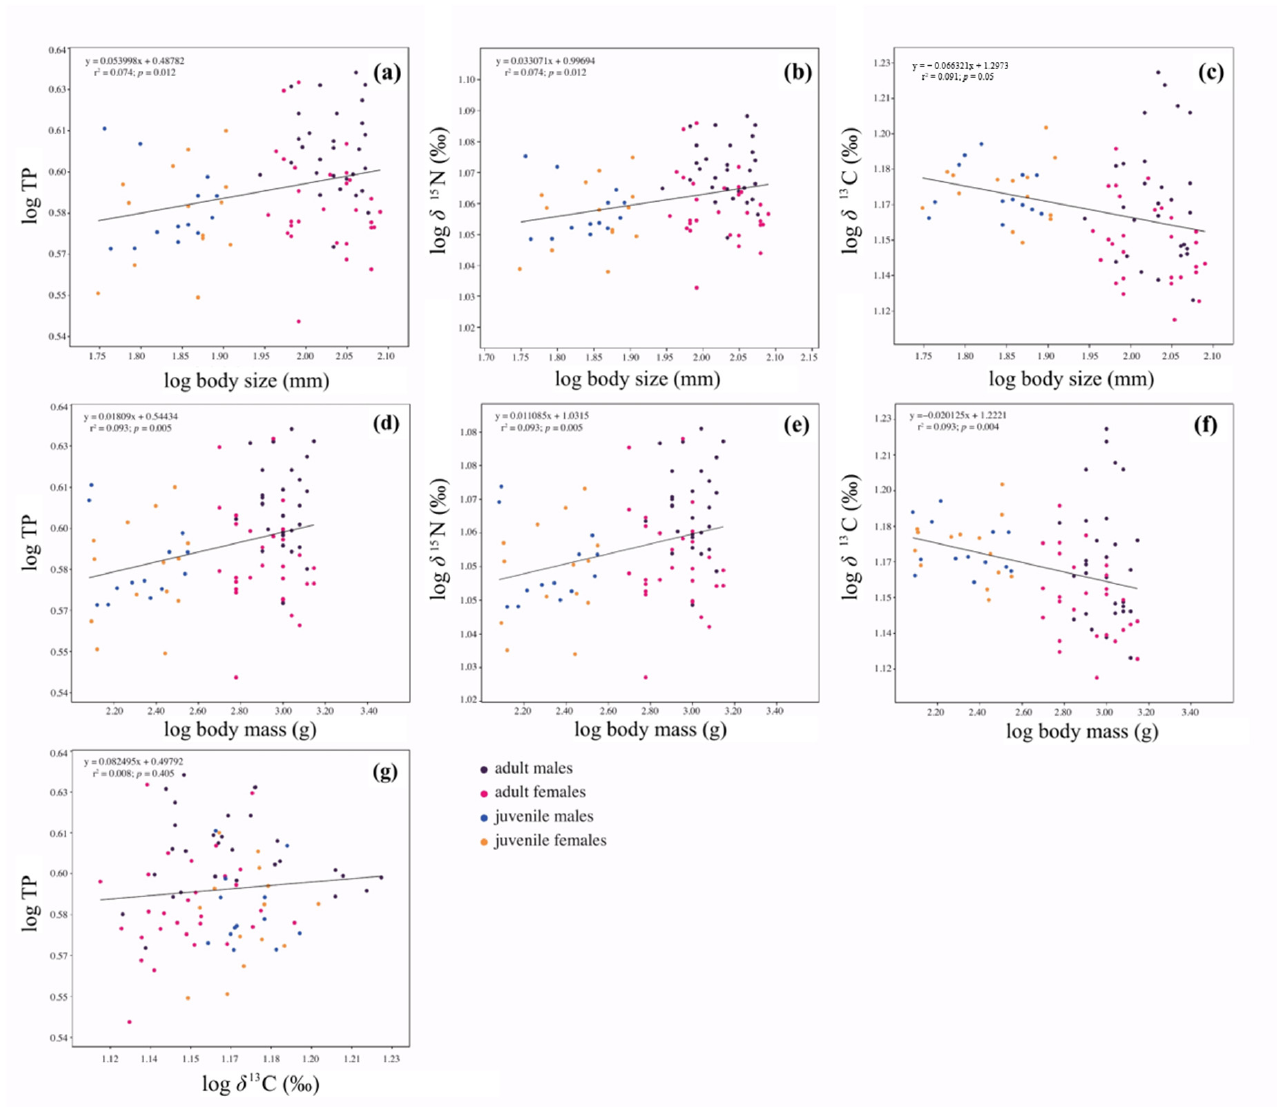
Figure 7. Relationships between: ( a ) body size vs. TP, ( b ) body size vs. δ 15 N, ( c ) body mass vs. δ 13 C, ( d ) body mass vs. TP, ( e ) body mass vs. δ 15 N, ( f ) body mass vs. δ 13 C, and ( g ) δ 13 C vs. TP for all individuals of the southern king crab Lithodes santolla , Nassau Bay, Cape Horn.